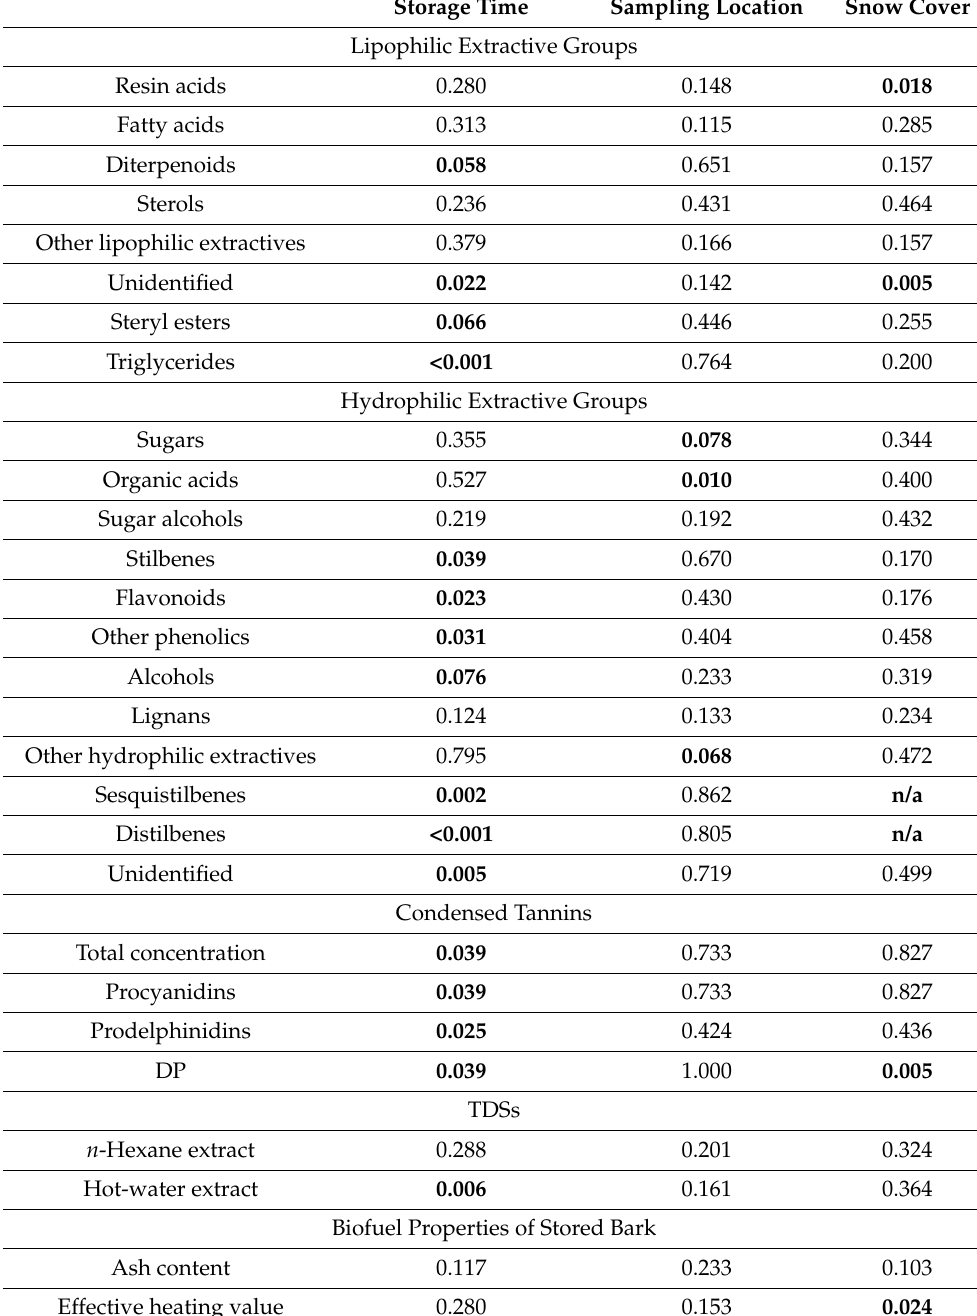
Table 1. Results ( p -values) obtained from testing the statistical differences among the storage duration (0, 4, 12 or 24 weeks), sampling location (middle, side or top) and snow cover (covered or not covered with snow) in terms of the amounts of lipophilic extractives, hydrophilic extractives, condensed tannins (CTs) and total dissolved solids (TDSs). The bold text indicates a statistically significant difference with a p -value less than